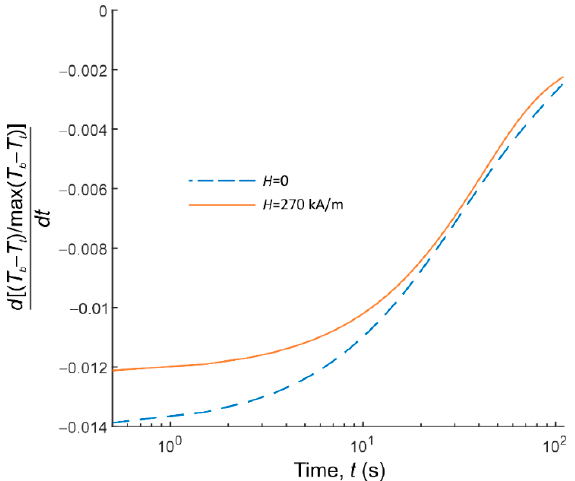
Figure 8. The time dependence of the normalized temperature difference between the bottom and top plates of the cell during cooling process. The results obtained in the absence and under the influence of a magnetic field are shown.